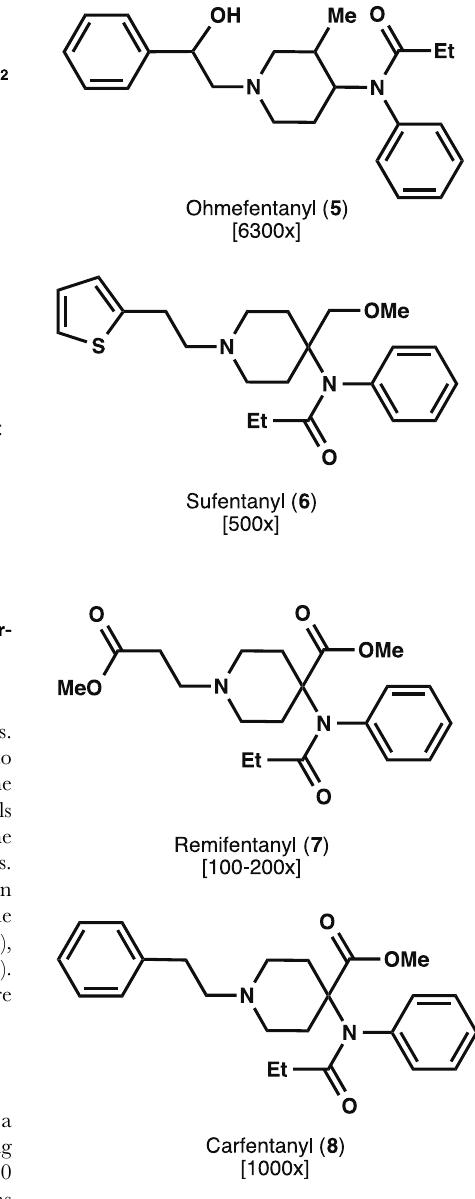
Figure 2. Fentanyl analogs and their potencies relative to morphine.